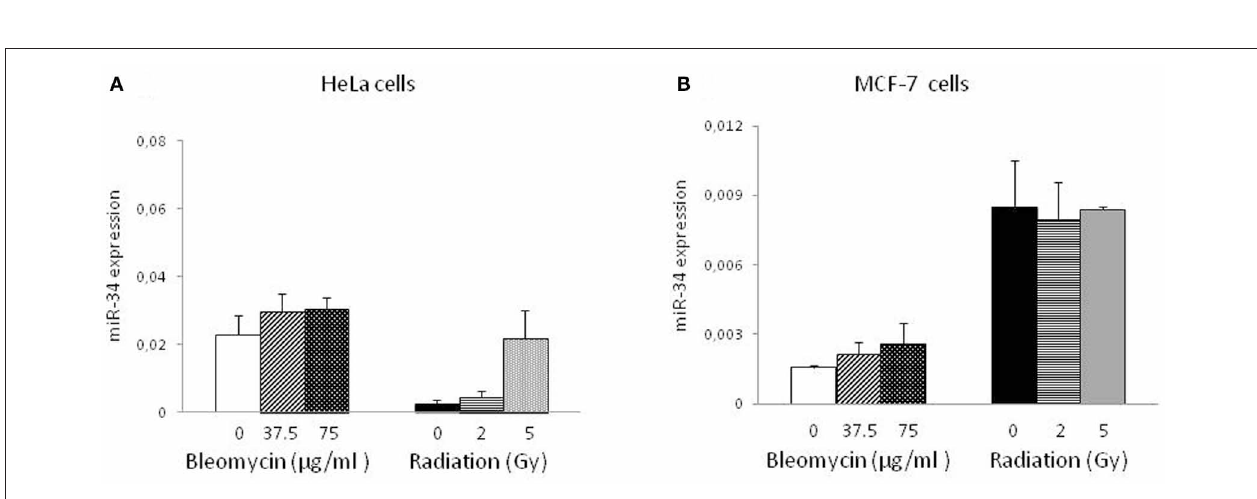
FIGURE 2 | miR-34 expression in HeLa and MCF-7 cells. miR-34 levels were measured by quantitative PCR in HeLa (A) and MCF-7 (B) cells exposed to genotoxic stress. Results of three-independentcell culture experiments were evaluated to calculate the average value of relative gene expression. Each column represents mean +